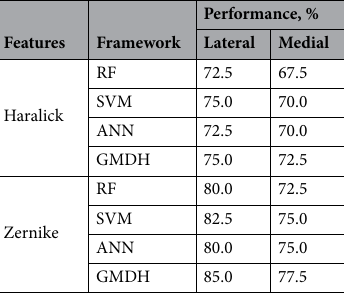
Table 1. Performances of the RF, SVM, ANN, and GMDH-type network using the Haralick and Zernike features.